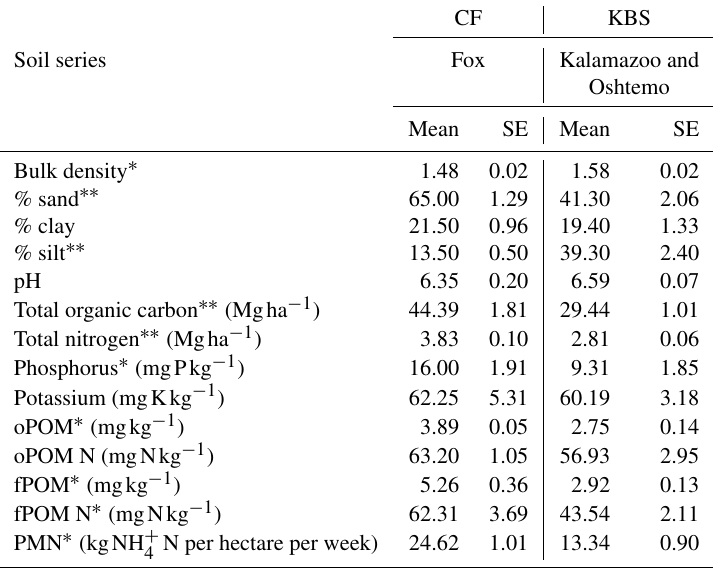
Table 1. Soil fertility indicators at each site. P values are indicated as follows: ∗ < 0 . 05 and ∗∗ < 0 . 001 for differences between sites.